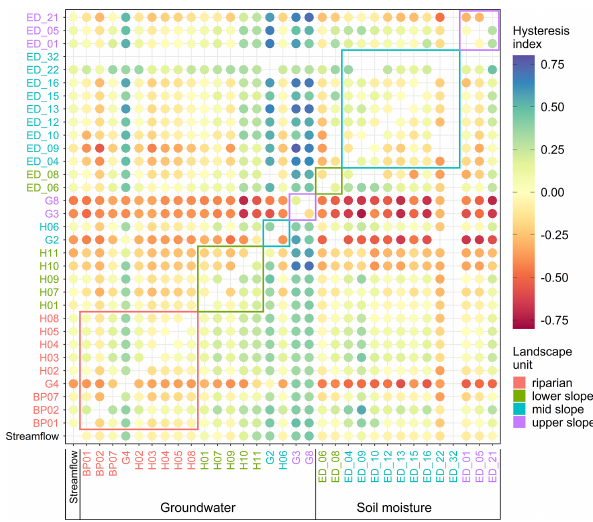
Figure 14. Median hysteresis index between median weekly streamflow at catchment outlet ( Q ), groundwater (BP ∗∗ , H ∗∗ , G ∗ ) and soil moisture (ED_ ∗∗ ) over the years 2017 and 2018. Hysteresis index is positive if the row station peaks before the column station and negative if the row station peaks after the column station. Cir- cles’ colour corresponds to the value of the hysteresis index. The station names’ colour corresponds to their landscape unit. Coloured rectangles enclose values of stations in the same landscape unit. Only time series longer than 45 weeks per year are